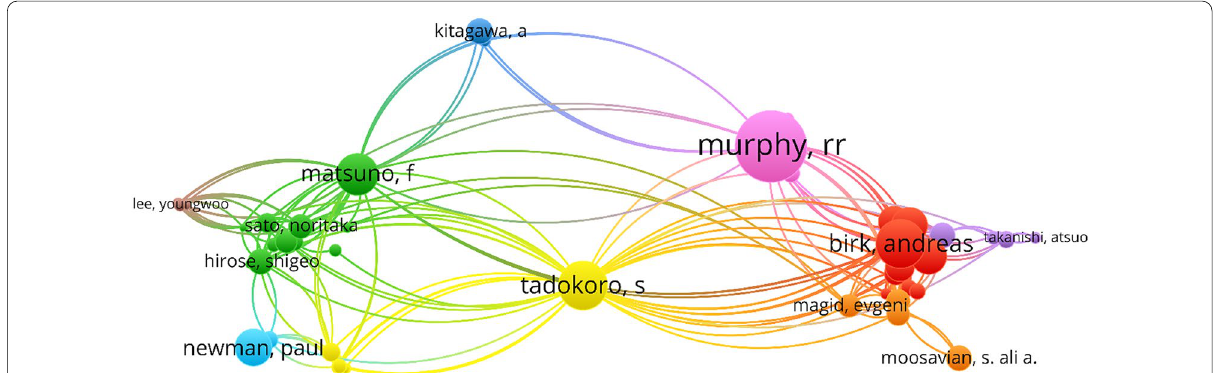
Fig. 3 Citation network of the active authors in RR generated via VOSviewer for authors having more than 5 citations